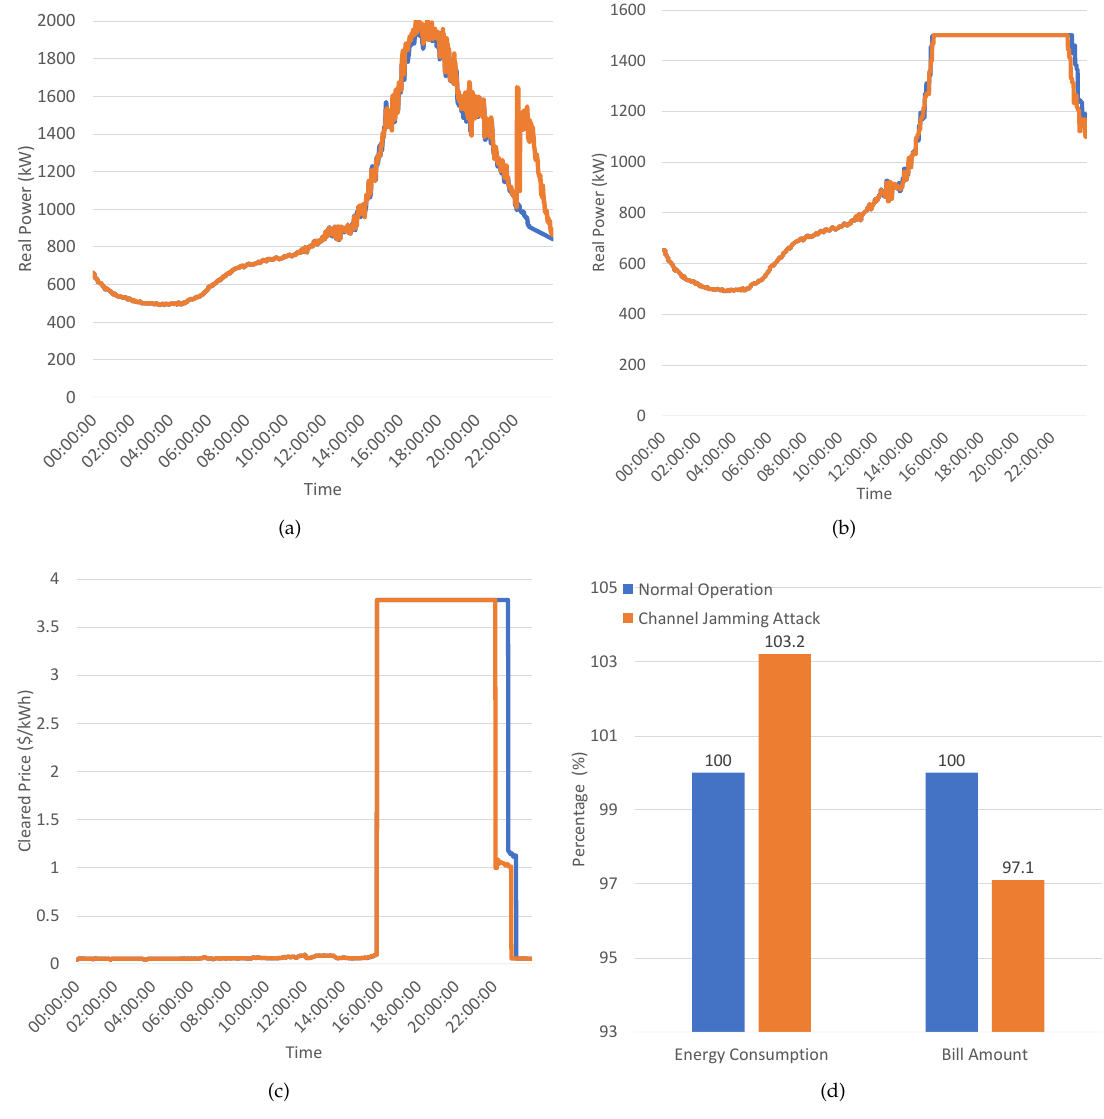
Figure 5. Channel jamming attack with the simple test feeder: ( a ) total load, ( b ) current market-clearing quantity, ( c ) current market-clearing price, and ( d ) economic impact of the